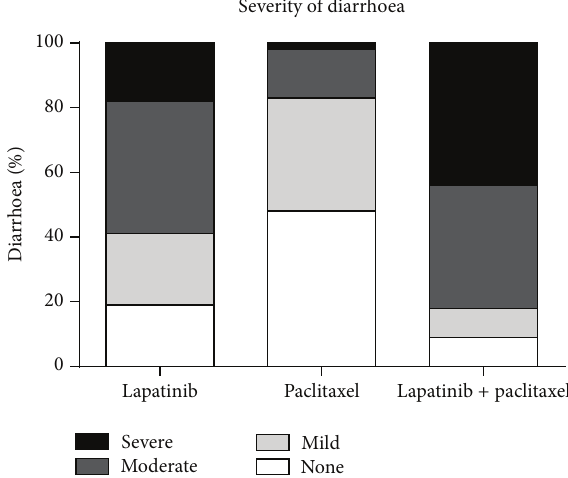
Figure 2: Diarrhoea incidence and severity. Data shown is pro- portion of rats that experienced diarrhoea at each severity level measured over the duration of treatment, 𝑛 = 30 . Addition of paclitaxel to lapatinib treatment caused a significant increase in the proportion of rats that experienced severe grade diarrhoea ( 𝑃 < 0.001 , chi-square